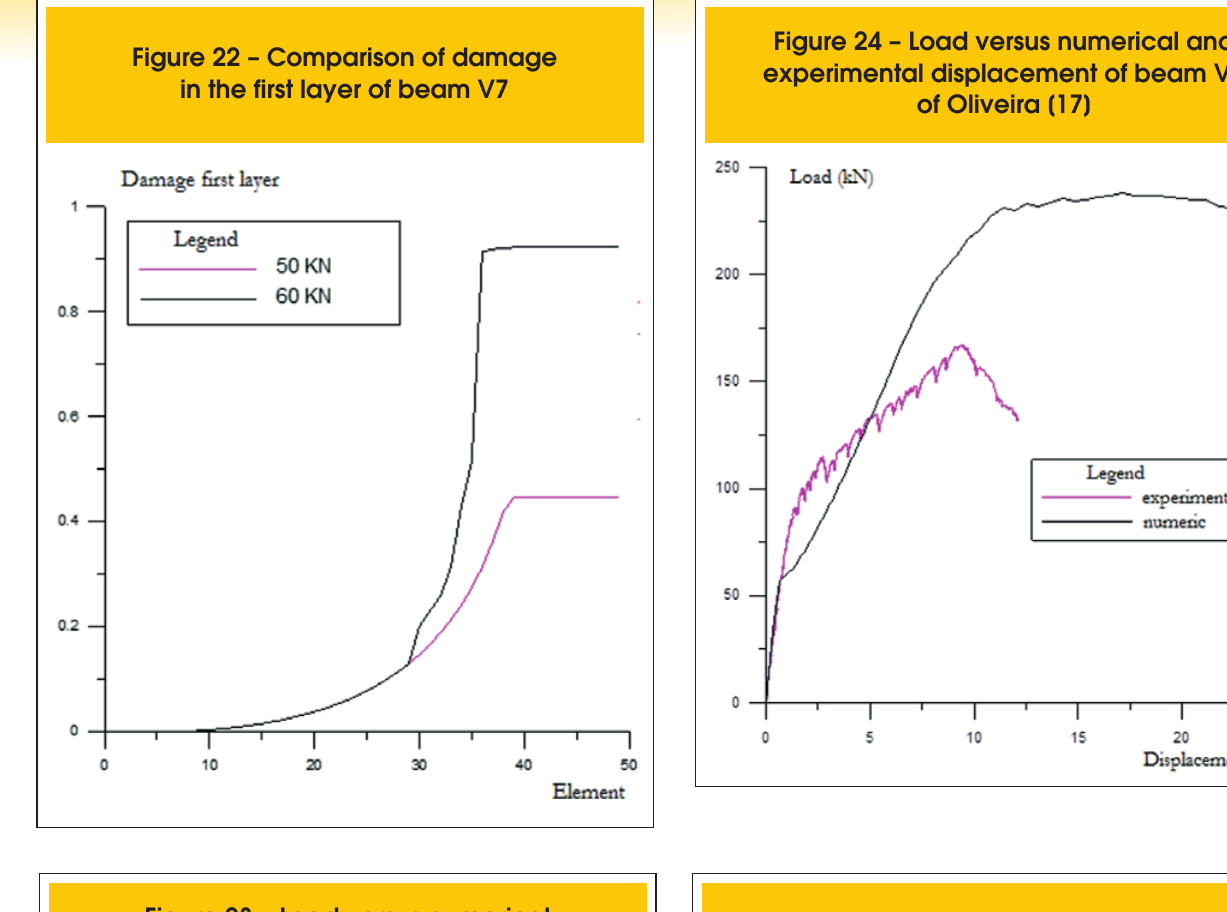
Figure 23 – Load versus numerical and experimental displacement